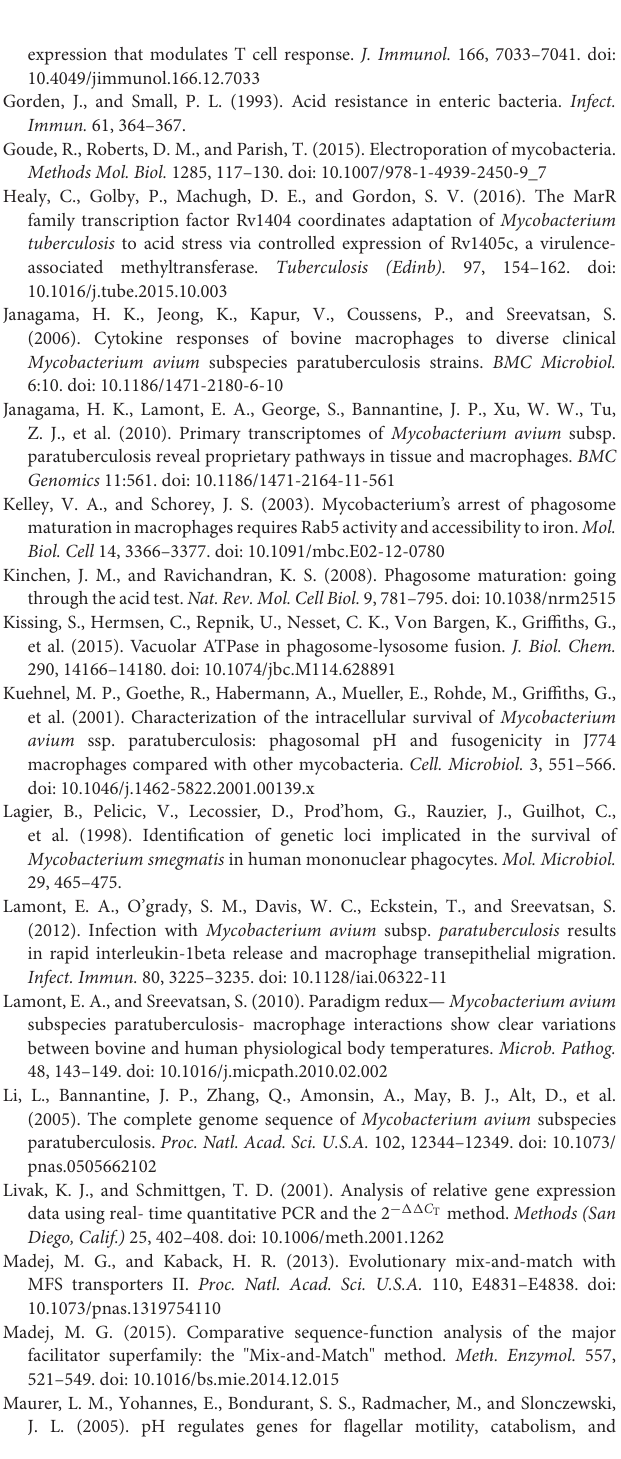
Figure S3 | M. smegmatis mc 2 155 intra-bacterial pH calibration curve. Intra-bacterial pH was measured by 5(6)-carboxyfluroescein N-hydroxysuccinimide fluorescence when exposed to a pH range of 4–8. Table S1 | Qt-RT-PCR primers used in this